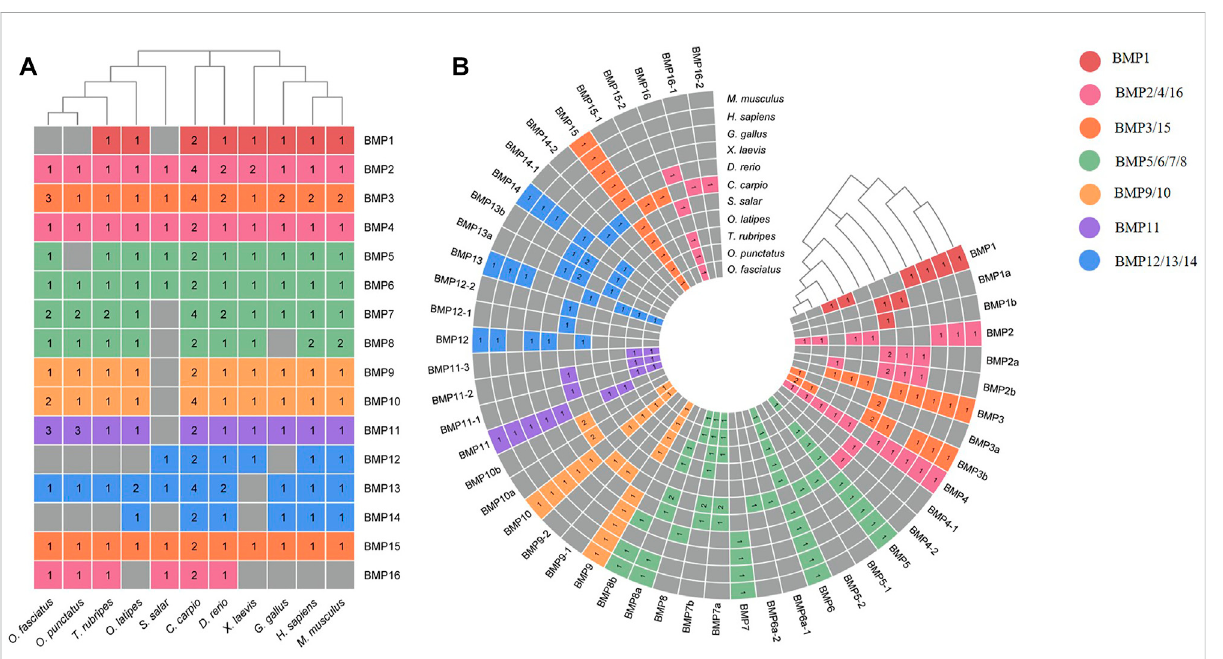
FIGURE 7 Heatmap of gene copy number comparisons of BMP genes in 11 species. (A) Shows a summary of the gene copy number comparison. (B) Showsthedetailedgenecopynumbercomparison.ThedifferentcolorsintheFigurerefertodifferentBMPsubfamilies,thenumbersontheheatmap indicate the number of gene copies, and the gray color indicates the deletion of the BMP